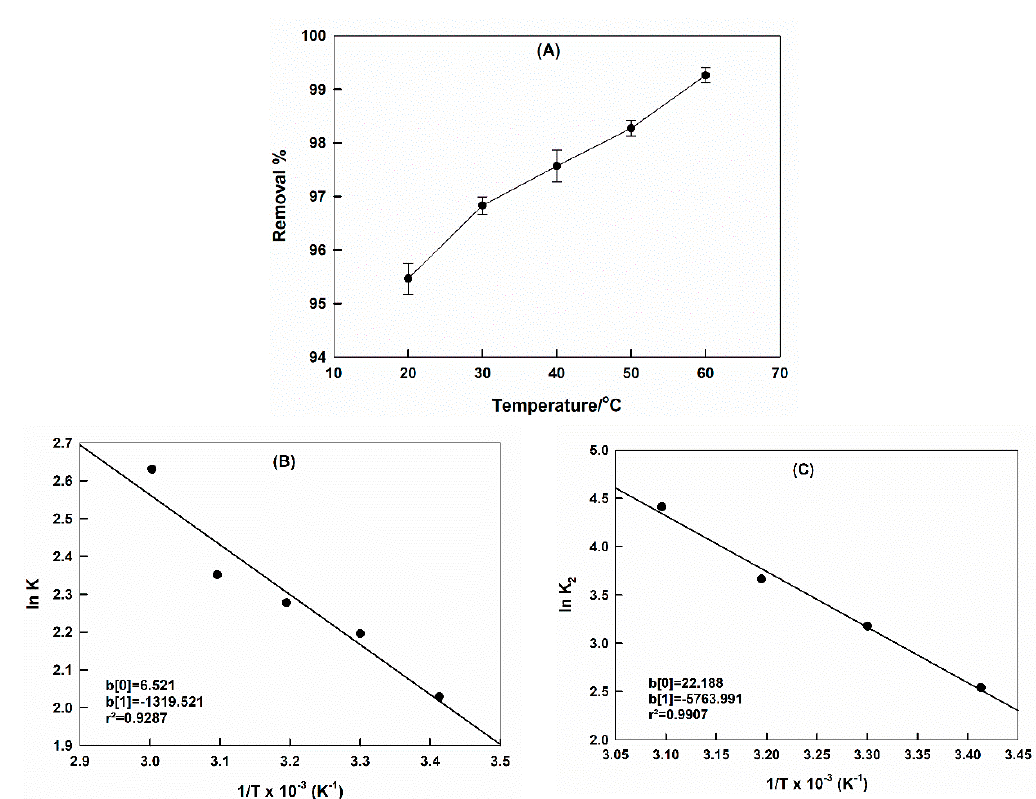
Figure 7. The relation between CR removal by CTAB-capped La 0.9 Sr 0.1 FeO 3 with temperature; pH =